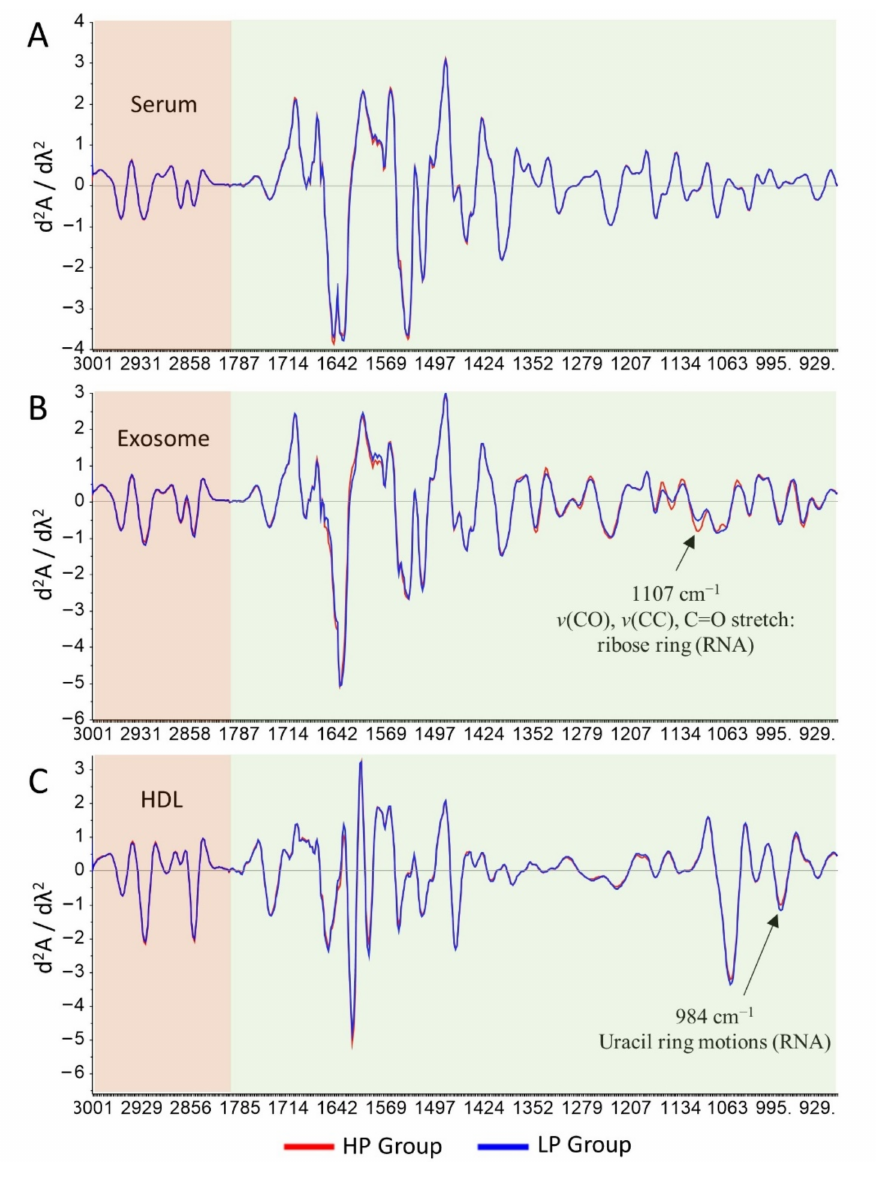
Figure 4. Averaged second derivative ATR-FTIR spectra with SNV normalization in the regions of 3000–2800 cm − 1 (pale-pink box) and 1800–900 cm − 1 (pale-grayish green box). Comparison of averaged second derivative spectra between LP and HP groups in serum ( A ), exosome ( B ), and HDL spectra ( C ). Comparison of band intensity was done by independent sample t -test. A significant difference in band intensity is depicted by the arrow ( → ). Blue and red represent the elderly groups with a low percentage (LP; ≤ 3%) and a high percentage (HP; ≥ 6%) of pathogenic CD4+ T cells,